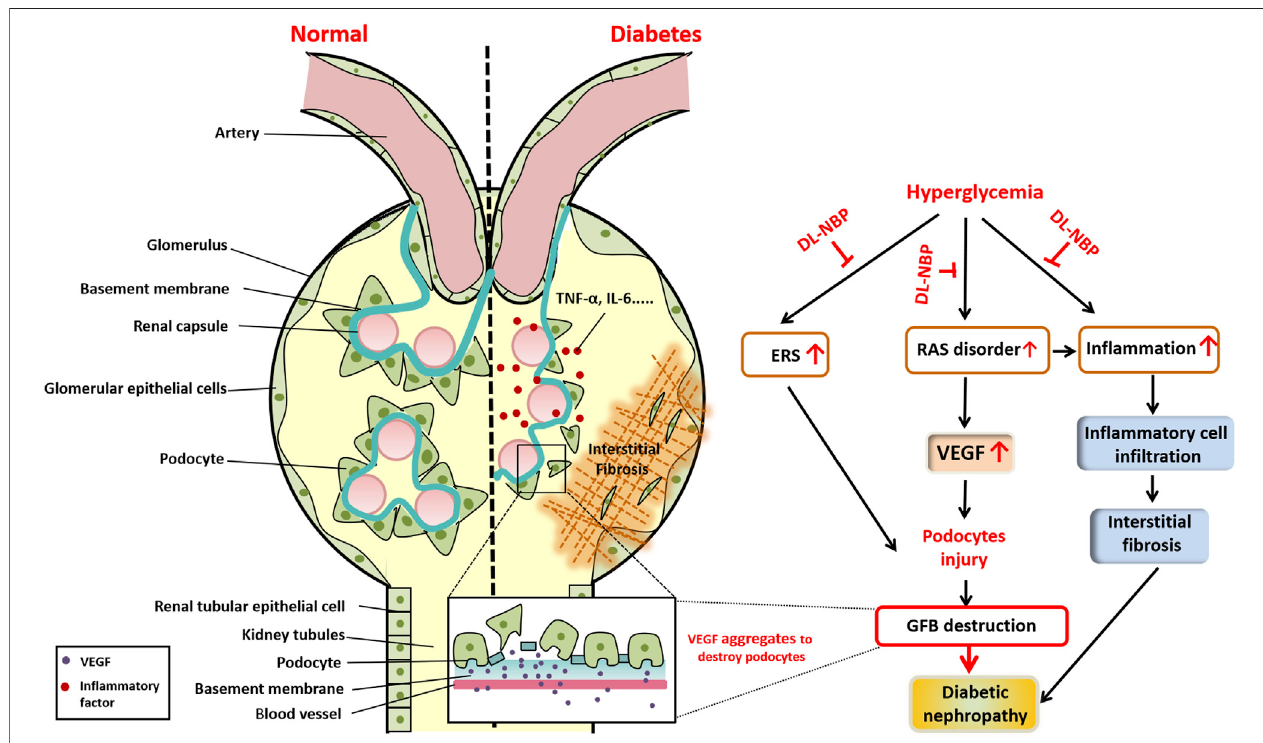
FIGURE 8 | Schematic showing the role and mechanism of DL-NBP in DN. Diabetes signi fi cantly induces renal interstitial fi brosis and podocyte apoptosis. The mechanistic study reveals that diabetes triggers ERS, induces excessive in fl ammation, and leads to RAS disorder, ultimately resulting in podocyte apoptosis. DL-NBP treatmentsigni fi cantlyreversestheseeffects and ameliorates DN.DN, diabetic nephropathy;ERS,endoplasmic reticulumstress;GFB, glomerular fi ltration barrier; RAS, renin-angiotensin system; VEGF, vascular endothelial growth factor.